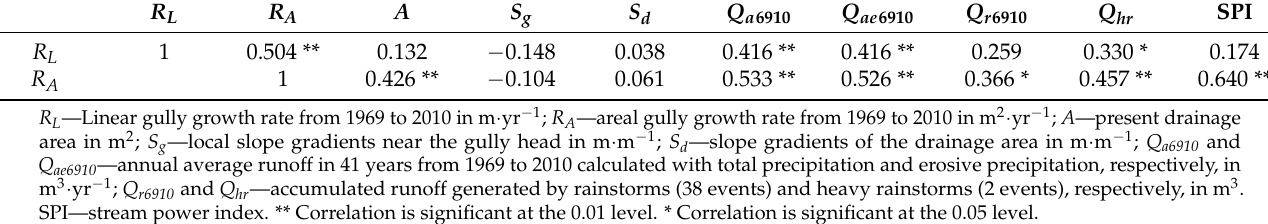
Table 5. Summary of the models of gully growth rates from 1969 to 2010 ( n = 45).